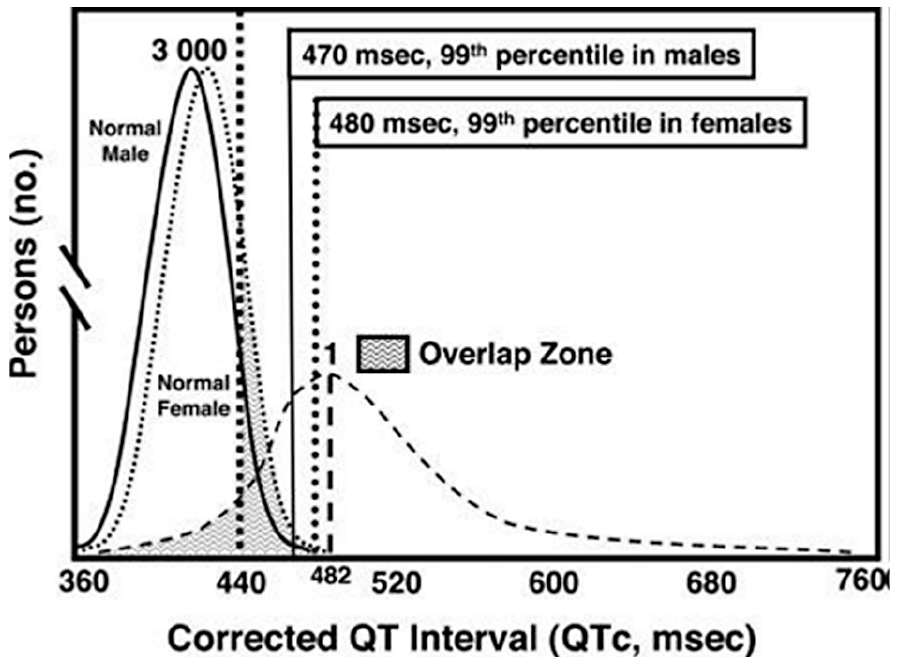
Figure 2. From reference [14], illustrates the distribution of QTc intervals in a cohort of patients with known LQT mutations, compared with male and female probands without known QT mutations. Reproduced with permission from Wolter Kluwer Health Inc.